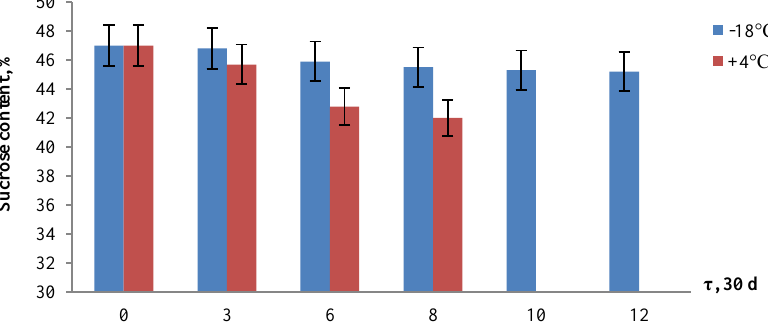
Fig. 2. Sucrose content of dates during storage at +4 °C and −18 °C.